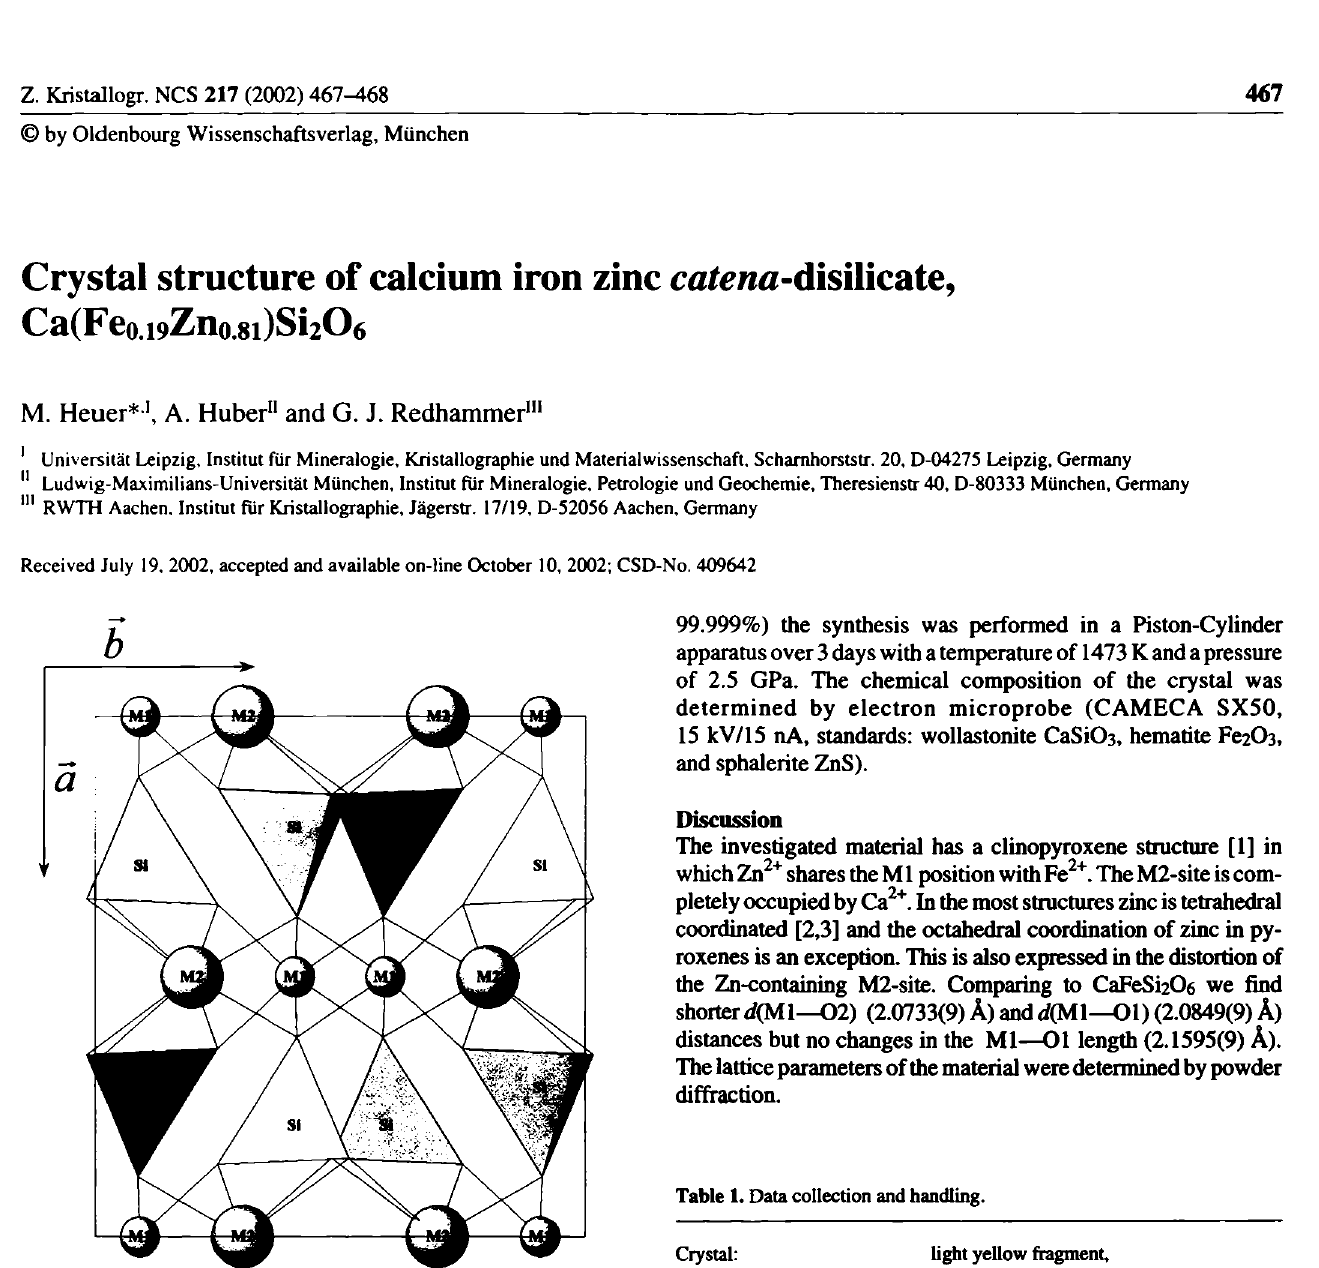
Table 2. Atomic coordinates and displacement parameters (in Â 2 ). Atom Site